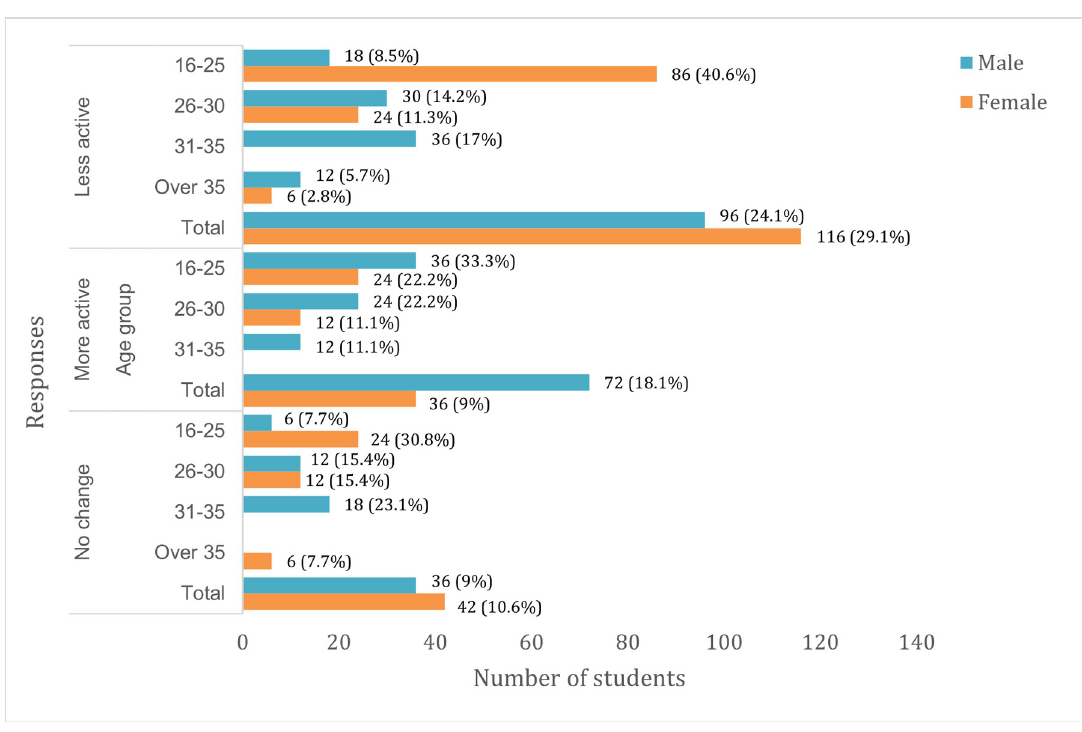
Fig 9. Student’s physical activity level.